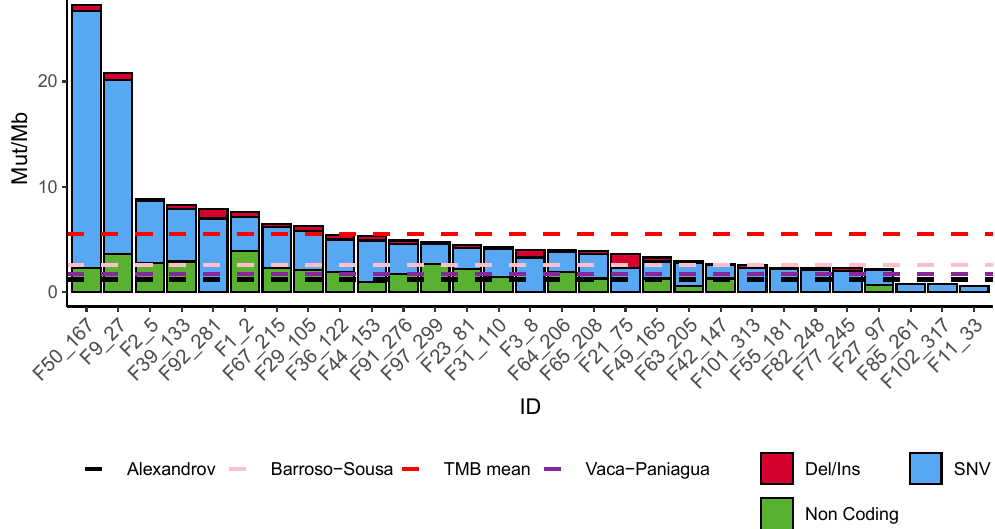
Figure 2. Tumor mutation burden (TMB) on each sample according to the type of variant. The type of mutation is indicated: Indels and deletions (red), single nucleotide variations (SNVs) (blue), and non-coding (green). The red dotted line is the mean TMB of our cohort and the black and purple dotted line is the TMB mean found by Alexandrov (2013), Vaca–Paniagua (2015), and Barroso–Sousa (2020) [49–51].